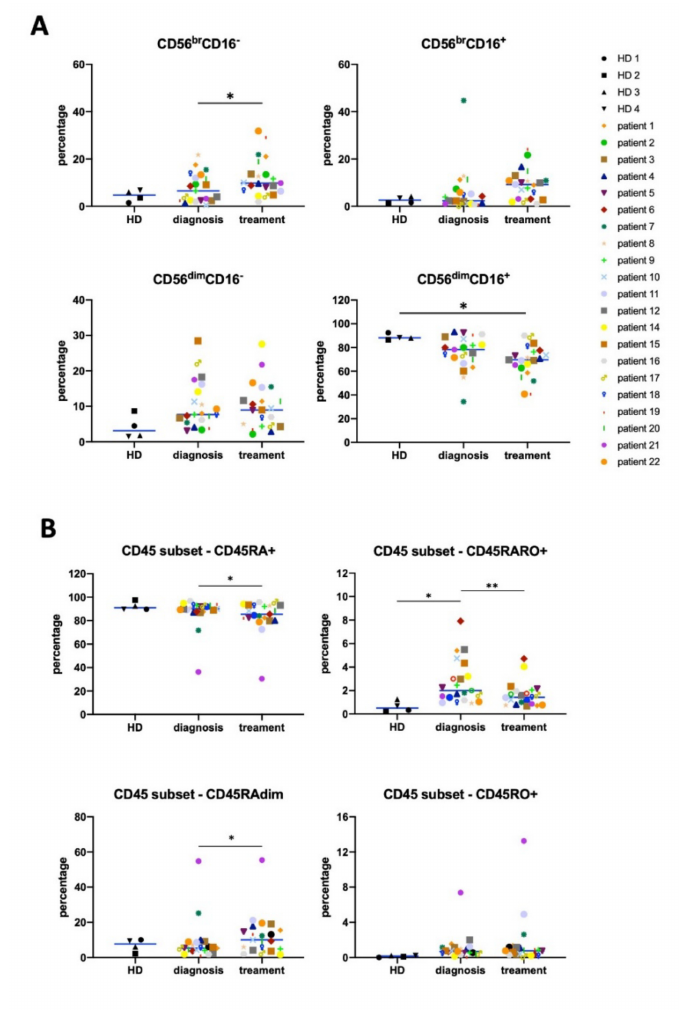
Figure 1. Hodgkin lymphoma (HL) natural killer (NK) cell subsets change after treatment. NK cell phenotypes were analyzed regarding expression of CD56 and CD16 ( A ), or CD45RA and CD45R0 ( B ), giving four di ff erent populations for each panel based on the expression of these markers. Statistical significance between HD ( n = 4) versus patients ( n = 21) were determined by one-way analysis of variance (ANOVA) (Dunnett’s correction). Statistical significance between “diagnosis” and “after treatment” for each patient was compared by the paired t-test, n = 21, * p ≤ 0.05, ** p ≤